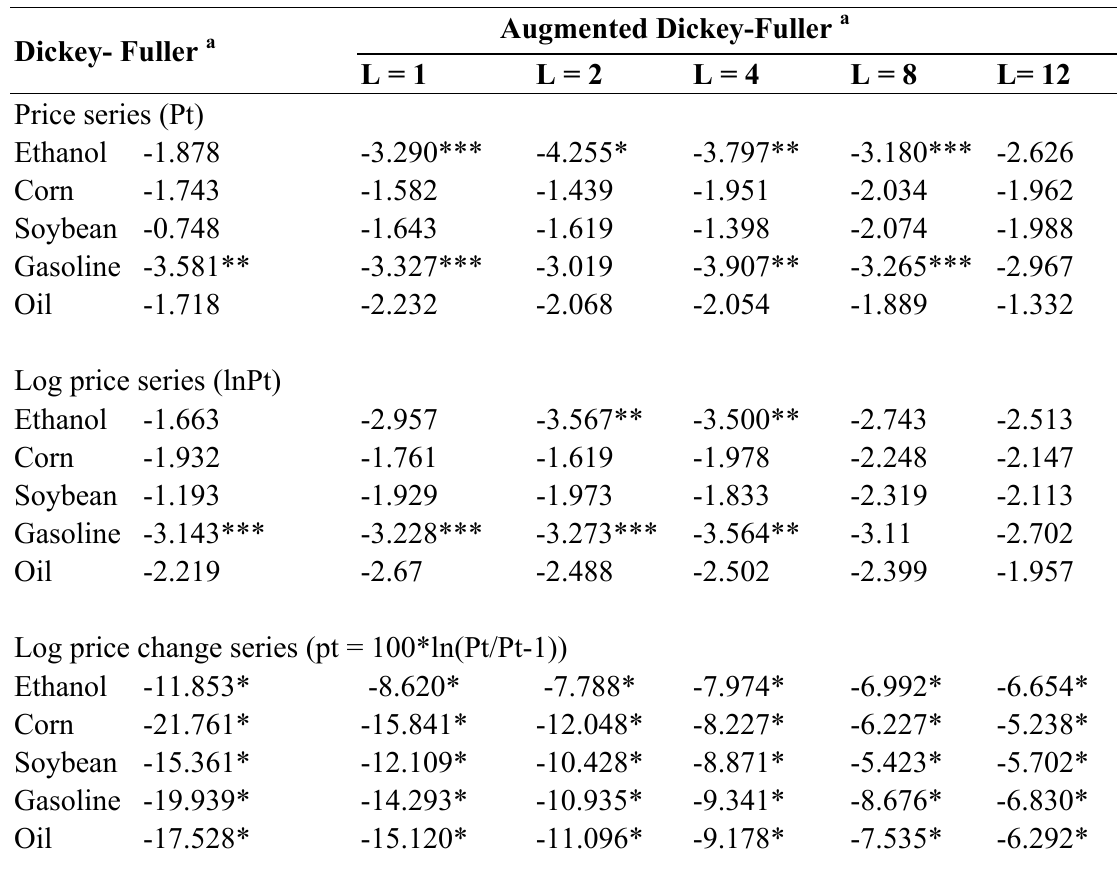
Table 2. Dickey –Fuller and Augmented Dickey –Fuller Unit Root Summary Statistics for the Ethanol Boom Years